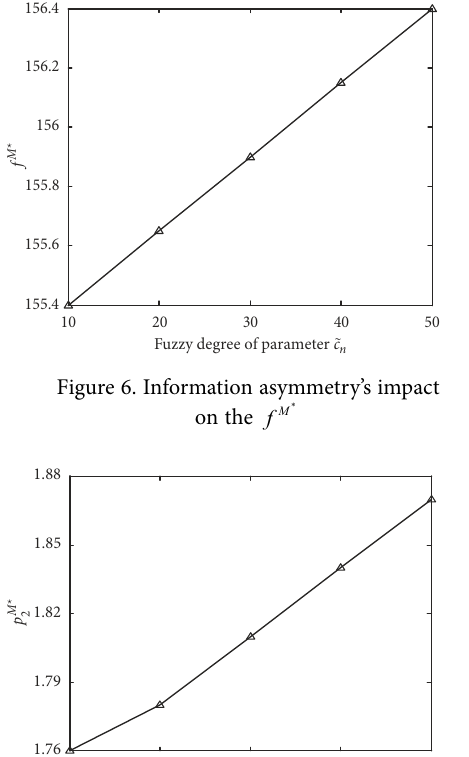
Figure 8. Information asymmetry’s impact on the